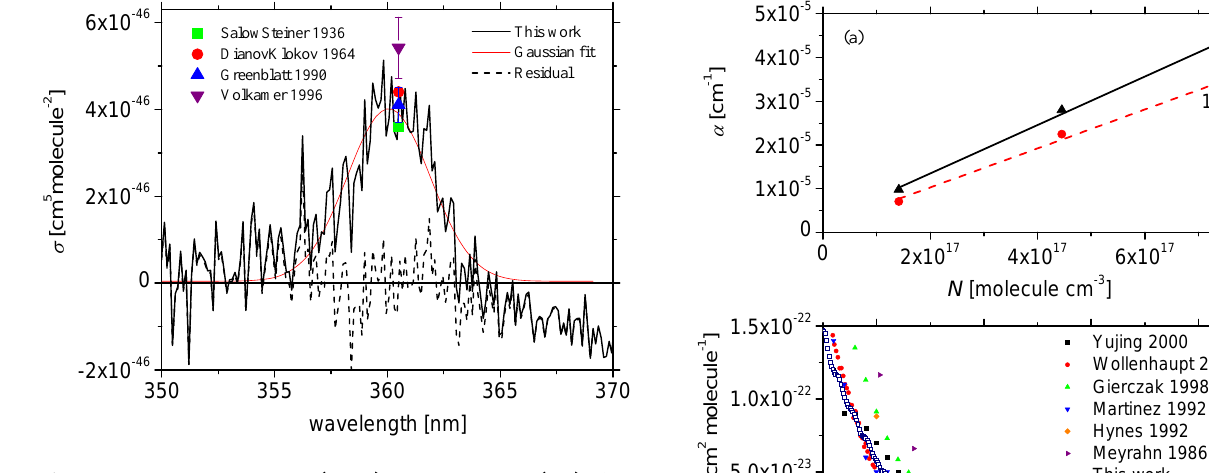
Figure 6. Experimental spectrum (black) and Gaussian fit (red) of the collision-induced absorption of the O 4 dimer. Literature maxima shown are those of Salow and Steiner (green square), Greenblatt (blue triangle), Dianov-Klokov (red circle), and Volkamer (purple triangle). To facilitate comparison with the literature maxima, our measured spectrum was shifted downwards by the offset of the Gaussian fit. Fig. 7. (a) Dependence of absorption coefficient on the acetone con-